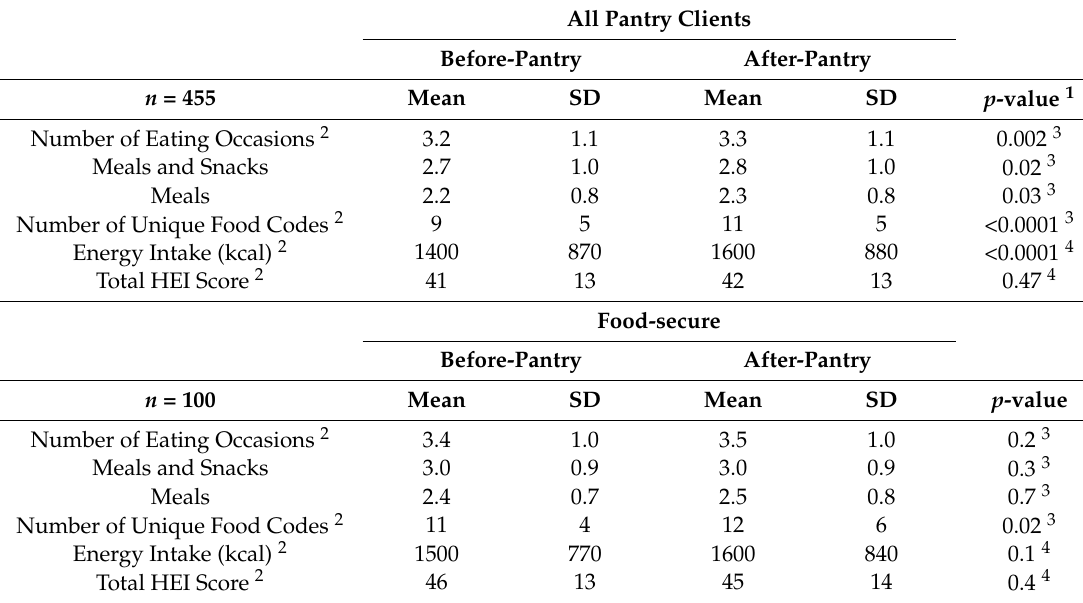
Table 2. Comparison of before and after pantry dietary intake patterns (number of eating occasions, number of unique food codes reported consumed, energy intake and total HEI-2010 score) for all, food-secure, and food-insecure pantry clients in a multistate sample of rural, Midwestern, adult emergency food pantry clients ( n =